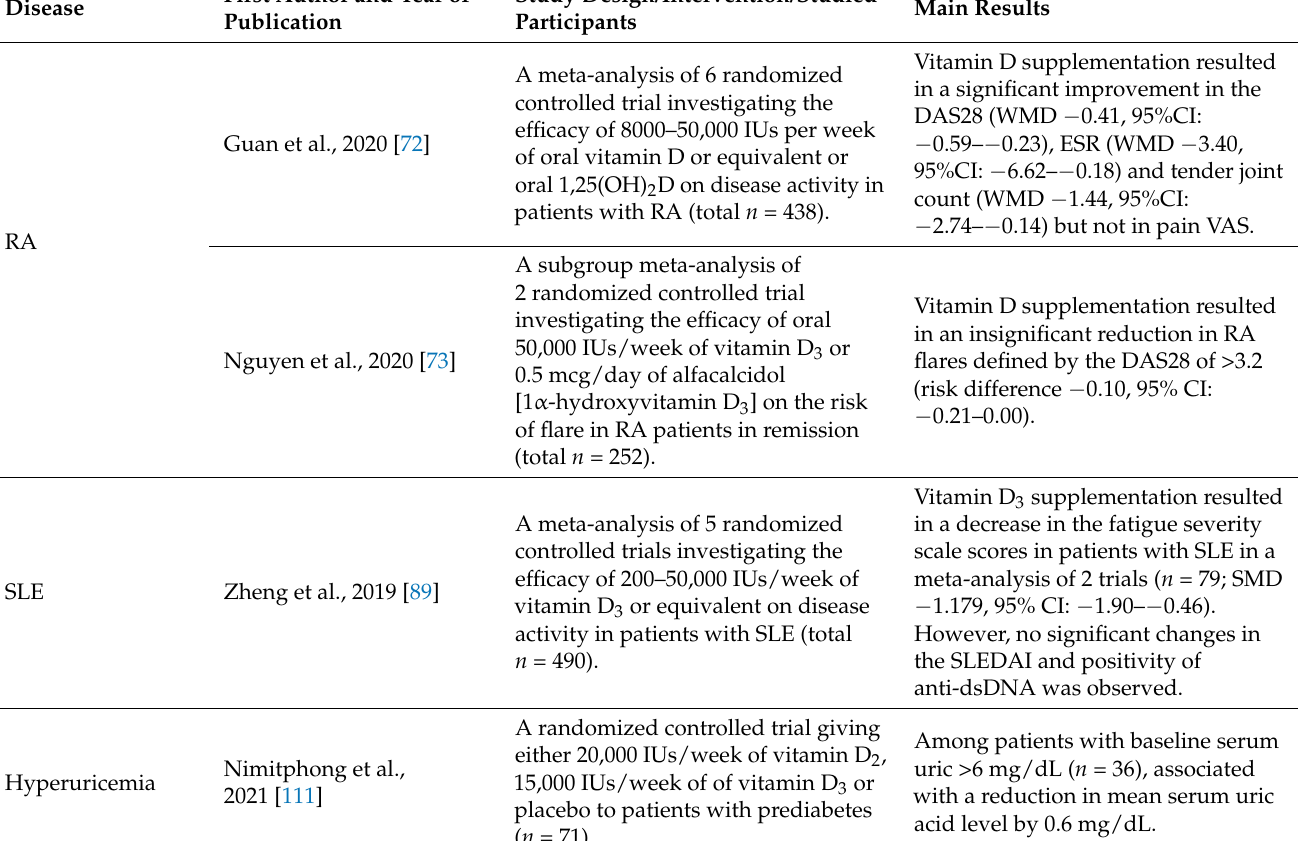
Table 2. Main characteristics of studies demonstrating the impact of vitamin D supplementation on clinical outcomes in patients with rheumatic